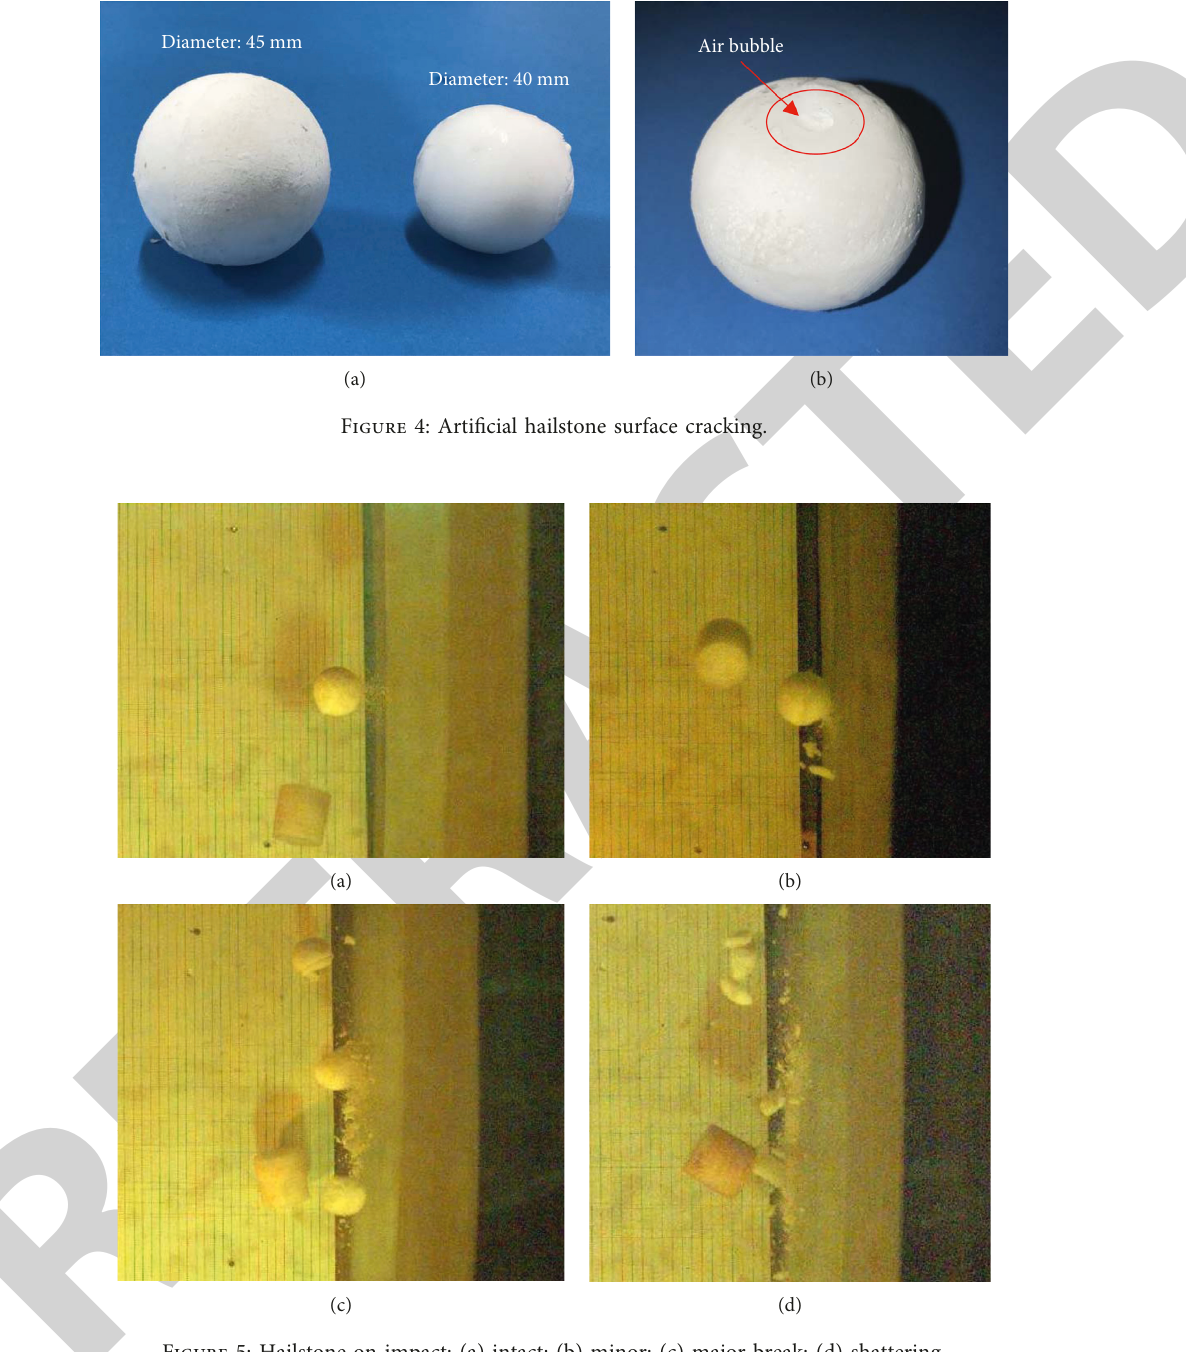
Figure 5: Hailstone on impact: (a) intact; (b) minor; (c) major break; (d)